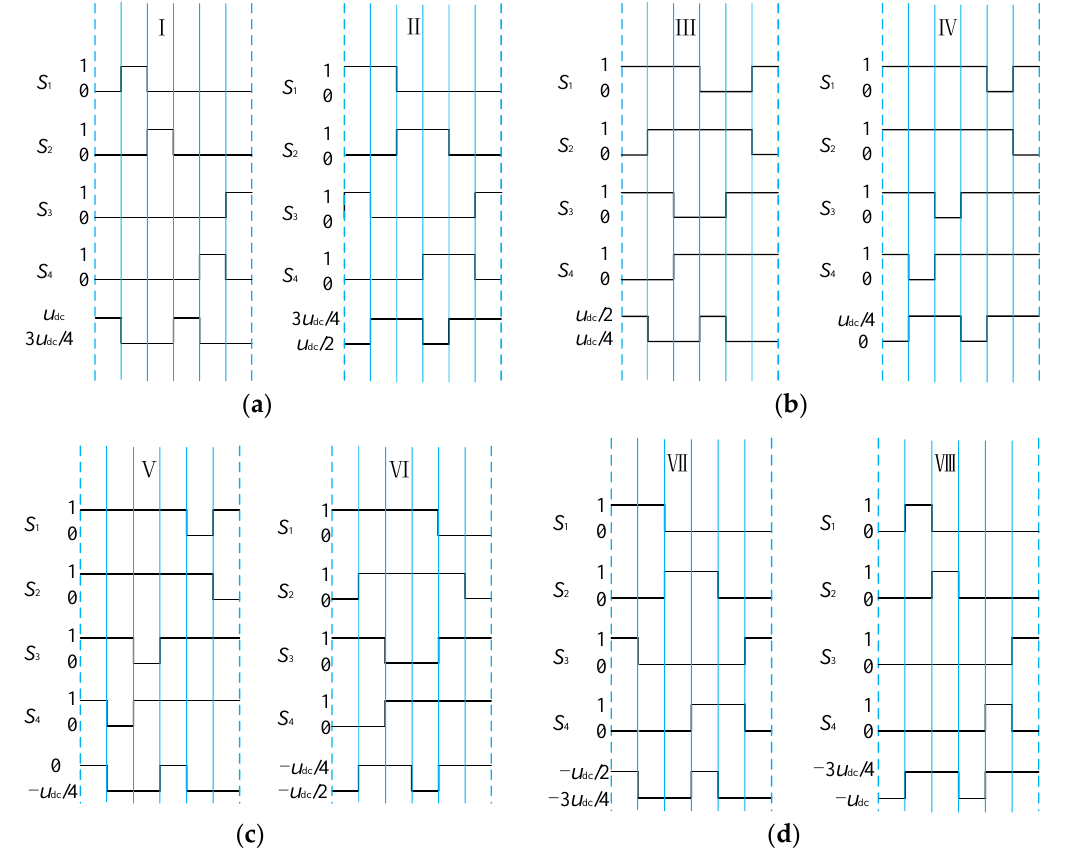
Figure 4. Switching states and output level corresponding to the SVPWM-1. ( a ) Sector I, II. ( b ) Sector III,IV. ( c ) Sector V,VI. ( d ) Sector VII,VIII.